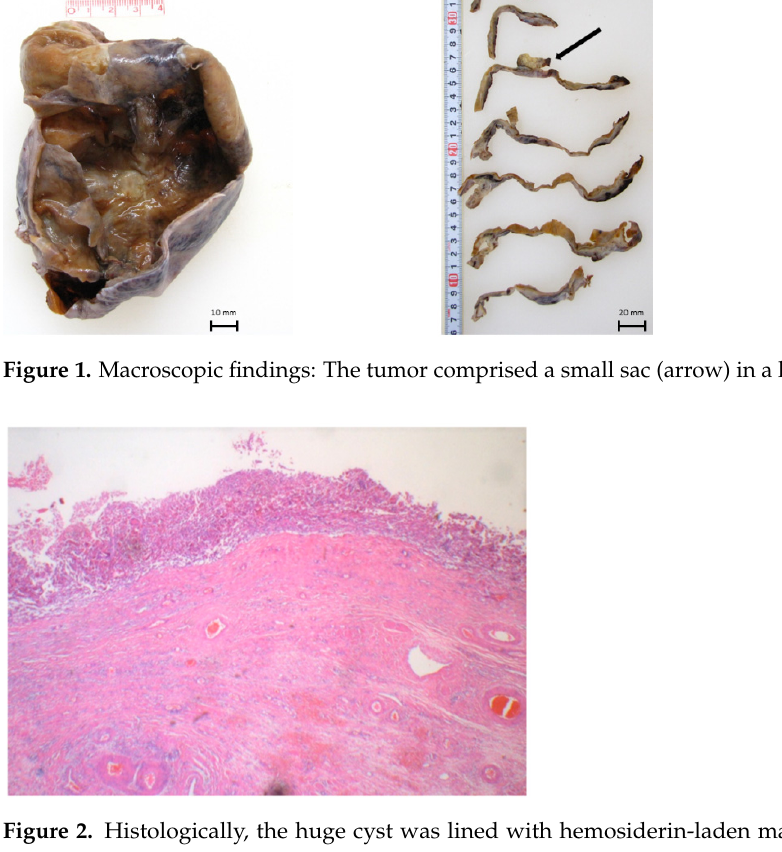
Figure 2. Histologically, the huge cyst was lined with hemosiderin-laden macrophages, and the epithelium was exfoliated (H&E staining) (5×).